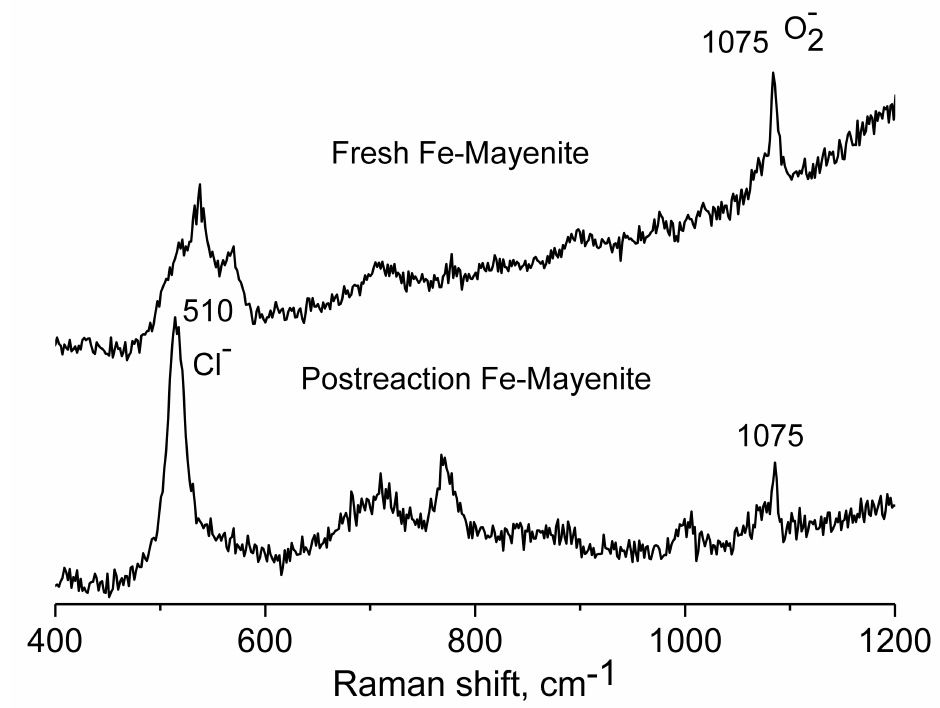
Figure 8. Raman spectra of Fe / mayenite (2.0%), fresh (top) and after reaction